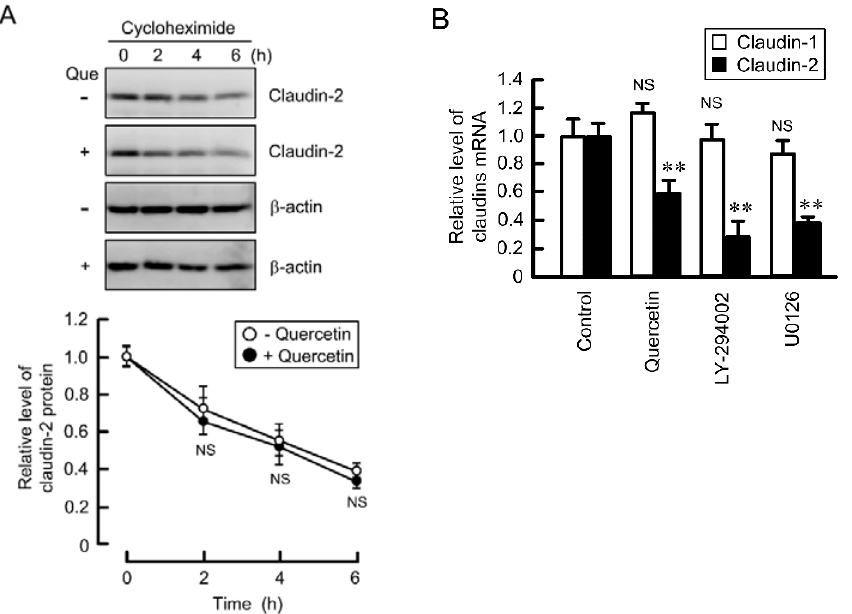
Figure 3. Effect of quercetin on the protein stability and mRNA level of claudin-2. ( A ) A549 cells were treated with 10 μM cycloheximide in the absence (−) and presence (+) of 50 μM quercetin for the period indicated. Cytoplasmic fractions were immunoblotted with anti-claudin-2 or β-actin antibody. The expression of claudin-2 was represented relative to the values in 0 h; ( B ) Cells were incubated in the absence (control) and presence of 50 μM quercetin, 10 μM LY-294002, or 10 μM U0126 for 6 h. The expression level of mRNA was quantified by real-time PCR using primers for claudin-1, claudin-2, and β-actin, and was represented relative to values at control. n = 3–4. ** p < 0.01 significantly different from control. NS, not significantly different.